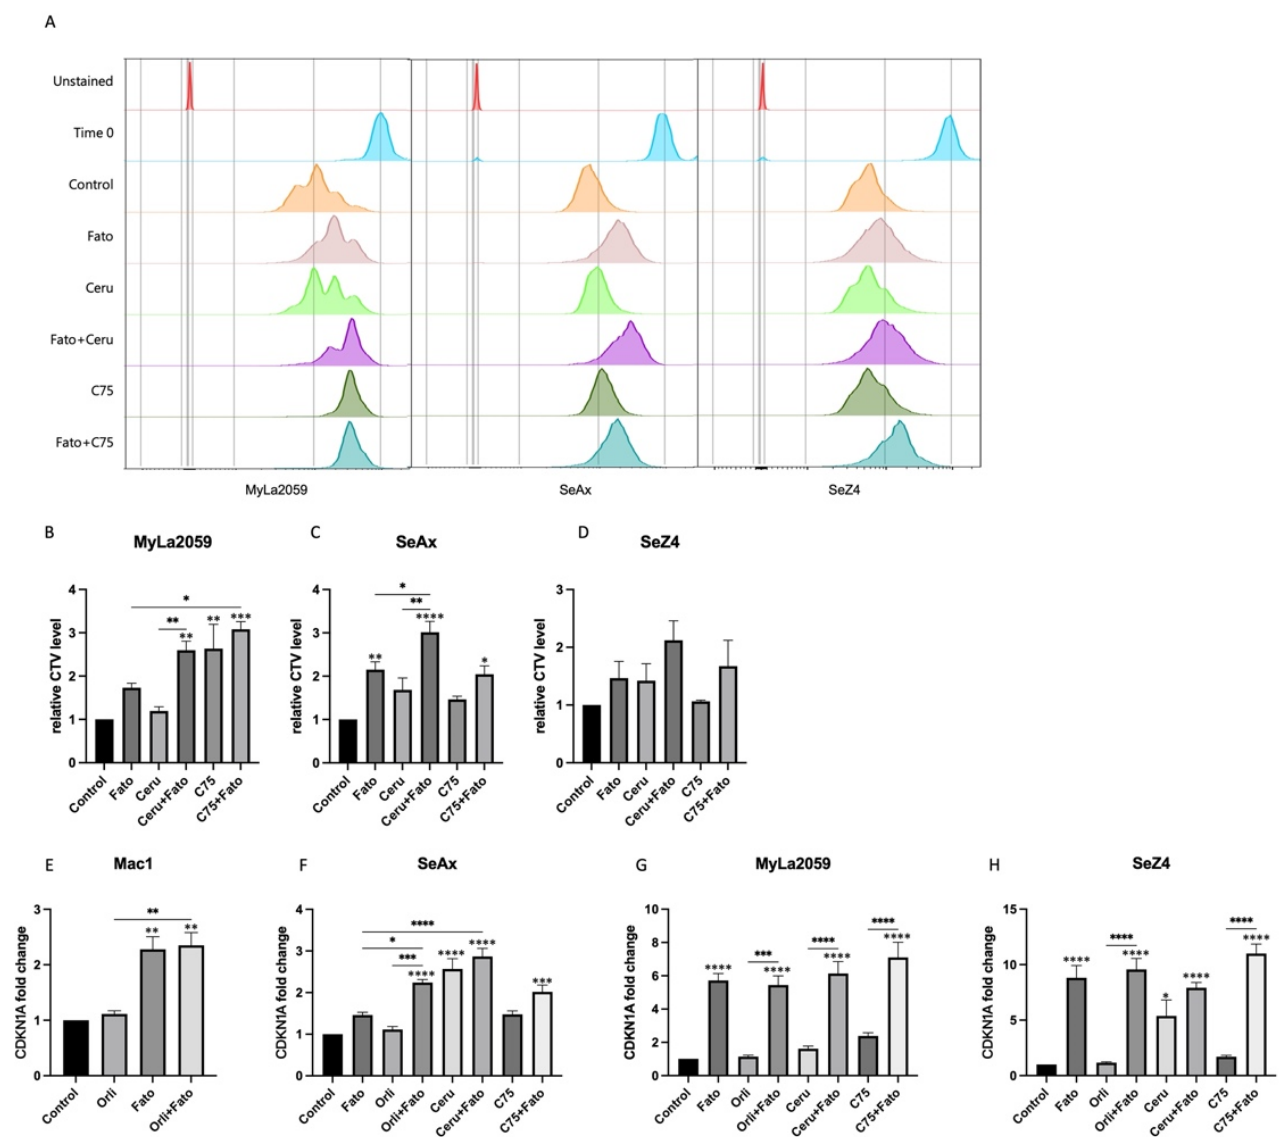
Figure 5. SREBP and FASN inhibitors impair cell proliferation and increase CDKN1A expression in CTCL cell lines. ( A ) Representative CellTrace violet (CTV) fluorescence intensity profiles of the indicated CTCL cell lines treated with the given inhibitors, and ( B – D ) illustrate the mean fluorescence intensity (MFI). ( C – H ) depicted the relative expression of CDKN1A in three CTCL cell lines treated with the indicated SREBP and FASN inhibitors. The expression levels were normalized to CDKN1A expression in untreated cells. Statical significance was calculated with a one-way ANOVA test with Tukey´s multiple comparison, as described in materials and methods. Asterisks above each column in ( B – H ) indicate the significance of difference compared to the control. Bars with asterisks signify the difference between an inhibitor and any combination with this inhibitor (* p ≤ 0.05; ** p ≤ 0.01; *** p ≤ 0.001; **** p ≤ 0.0001).